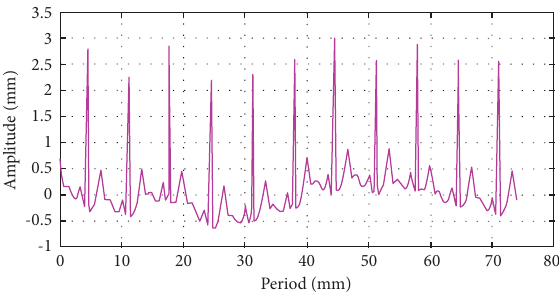
Figure 5: Masking ECG image.